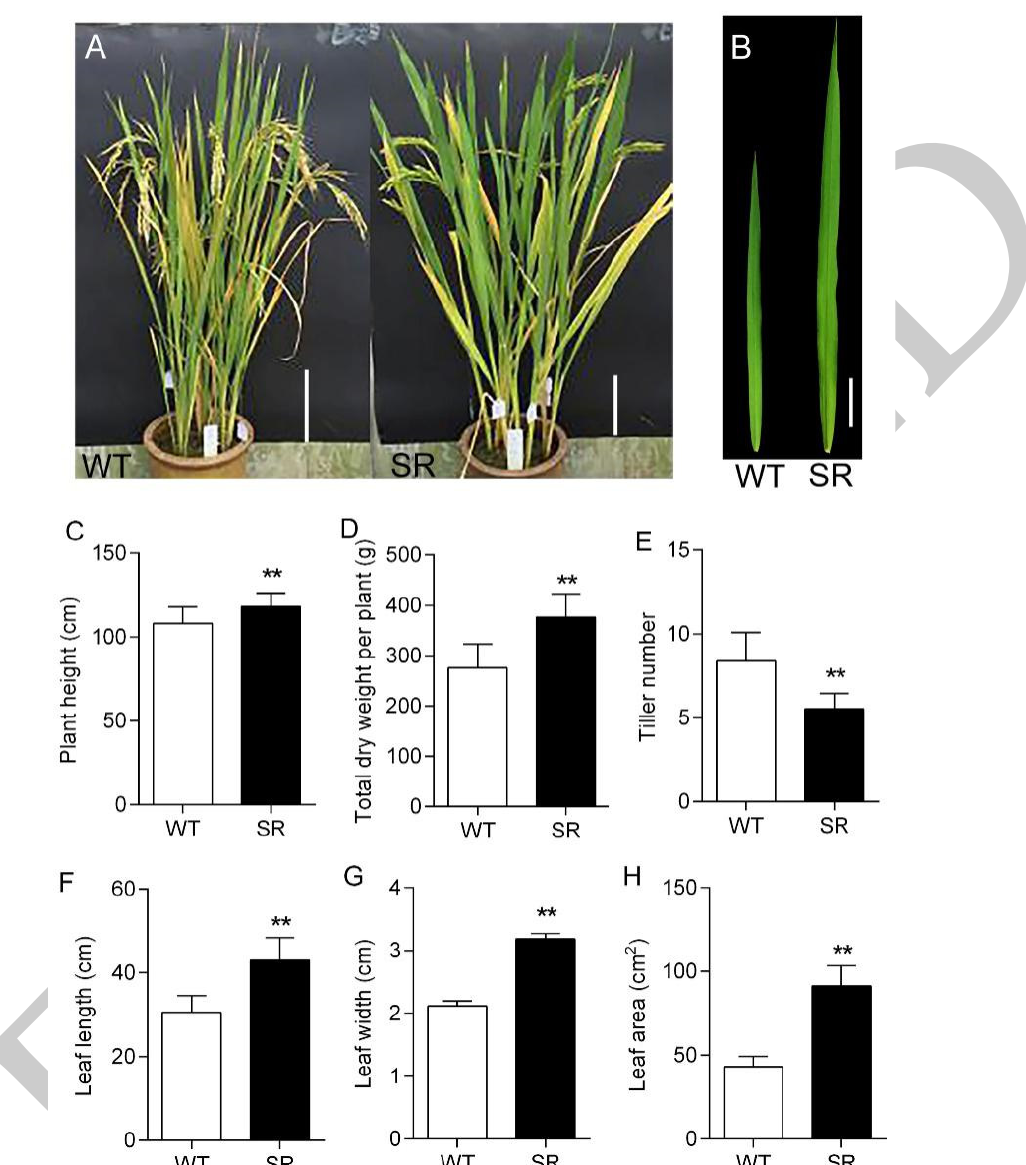
Figure 2. Characteristics of wild type (WT) and transgenic plant sorghum–rice (SR). ( A ) Phenotypes of WT (left) and SR (right) at 21 days after flowering (DAF). Bars, 20 cm. ( B ) Magnified views of a flag leaf taken 7 DAF from WT (left) and SR (right). Bar, 5 cm. ( C – H ) Increased vegetative biomass in SR. Plant height ( C ), total dry weight per plant ( D ), tiller number ( E ), flag leaf length ( F ), flag leaf width ( G ), and flag leaf area ( H ) of WT and SR. Values ( C – H ) are given as means ± SD ( n ≥ 15). Asterisks indicate significant differences between WT and SR. ** p < 0.01 compared with WT by Student’s t -test.